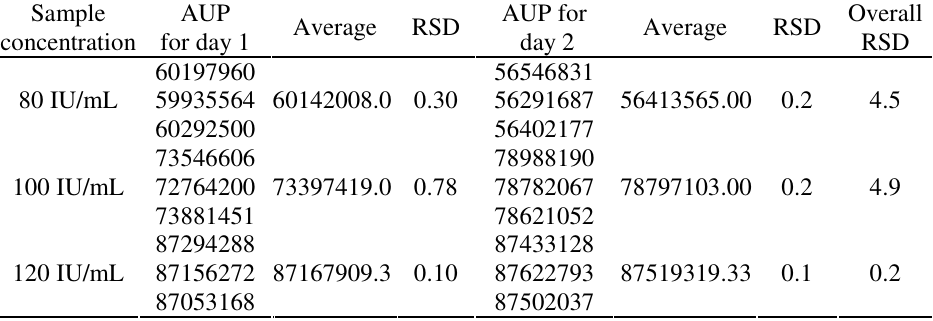
Table 5. Precision of the modified RP-HPLC assay for determination of insulin determination